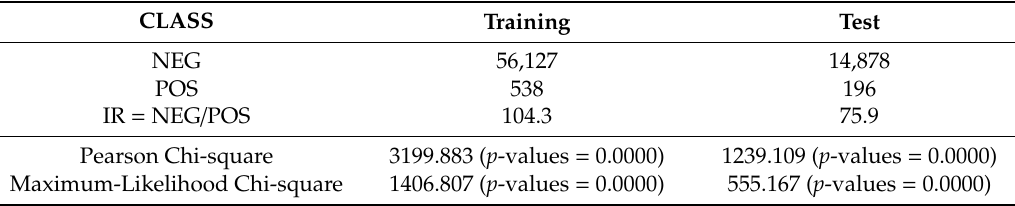
Table 3. The imbalance ratio (IR) check and Chi-square test for attribute ac_000.